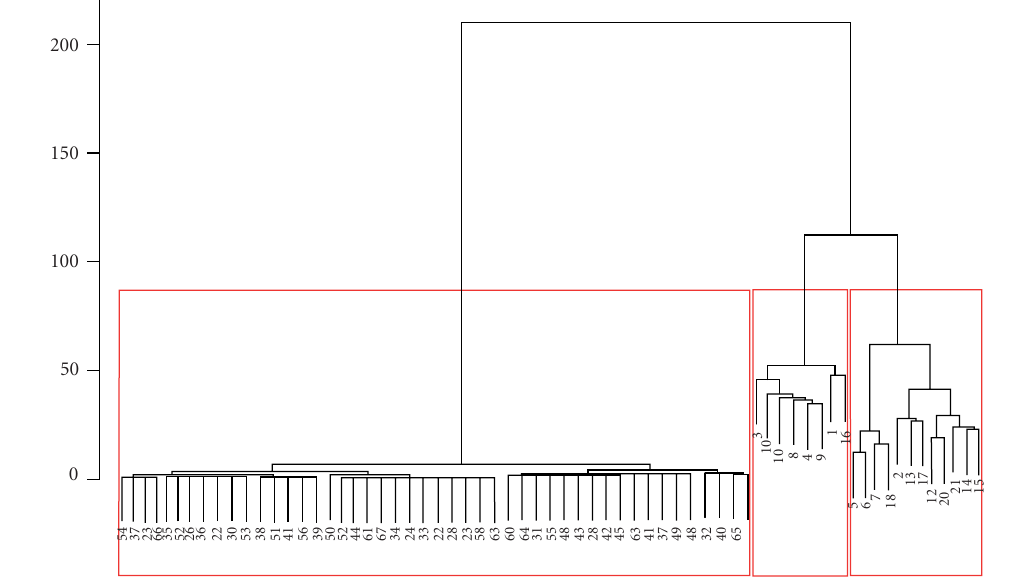
Figure 7. Dendogram of the δ B dissimilarity approach with Diana.